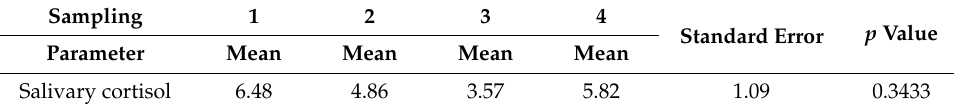
Table 10. Salivary cortisol concentration (ng/mL) during the